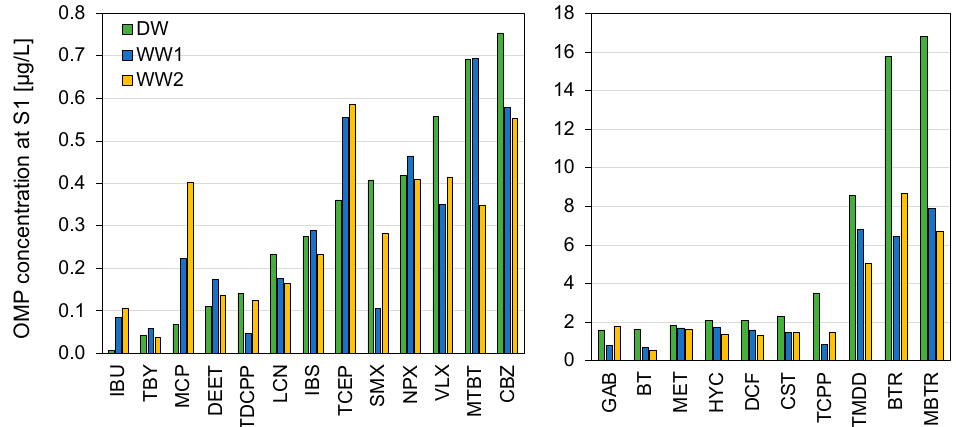
Figure 4. Concentrations of 23 organic micropollutants of dry- (n = 1) and wet-weather sampling (n = 2) at the effluent of the secondary clarifier (S1).